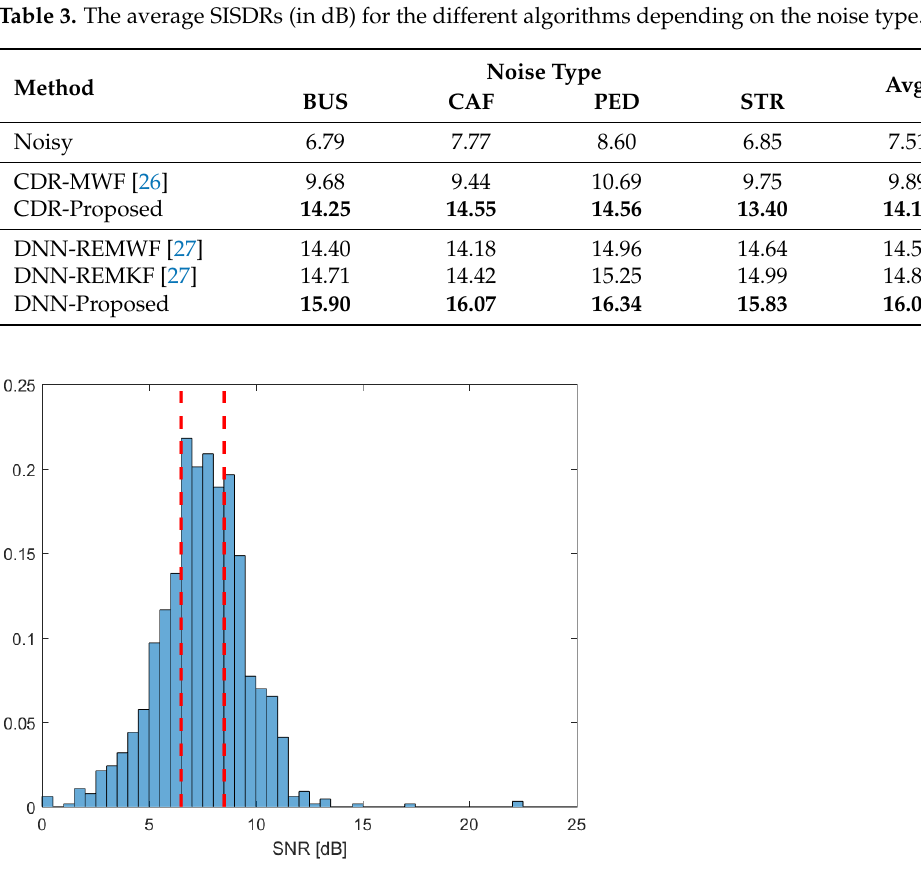
Figure 3. Normalized histogram of the SNRs in dB scale for the utterances in the evaluation set of the CHiME-4